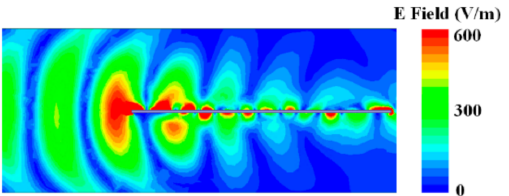
Figure 7. Electric field distribution of the antenna in Figure 4 at 6.6 GHz in YOZ